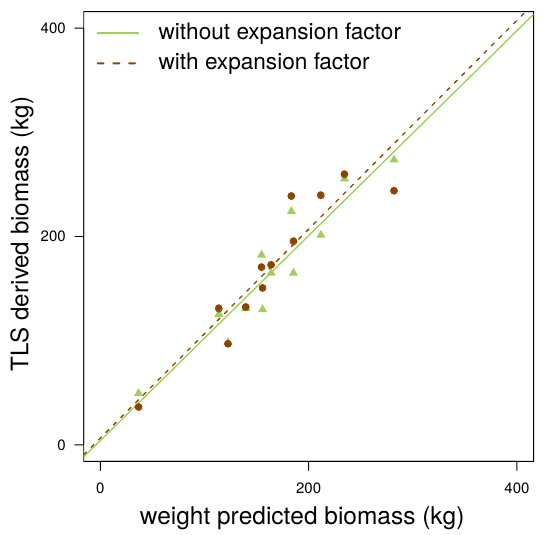
Figure 16. Two linear models utilizing both the weight predicted biomass of 12 P. massoniana as independent and either the TLS derived biomass from the total volume (f( x ) = 0.98 x + 4.06, adj. r 2 = 0.88 ) or the TLS derived biomass from the volume of compartments with a diameter larger than 10 cm expanded with a biomass expansion factor (f( x ) = 1.00 x + 6.46, adj. r 2 = 0.85 ) as dependent